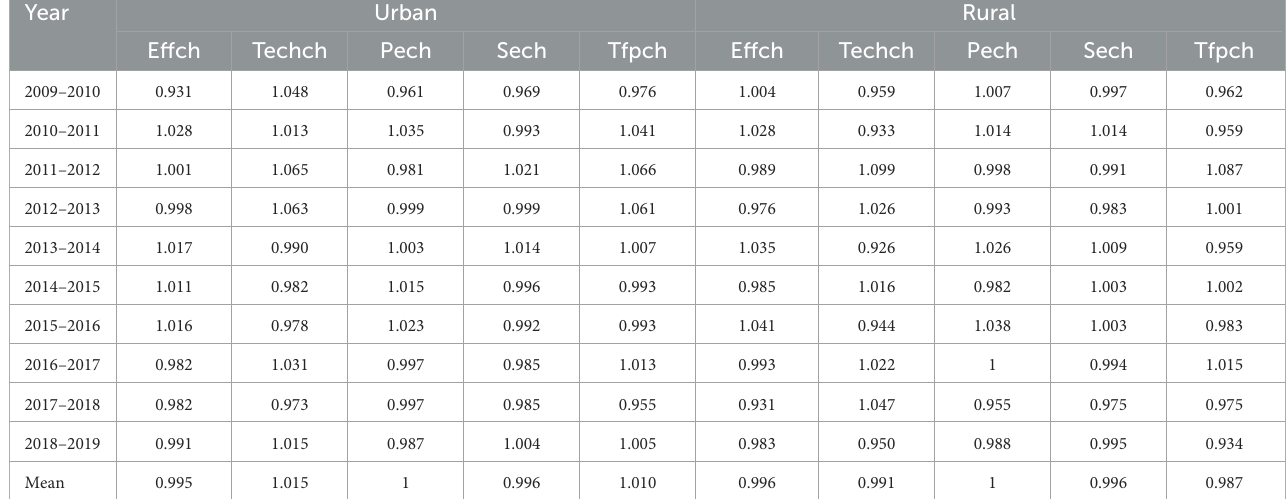
TABLE 4 The Malmquist index and its decomposition for PHCIs,